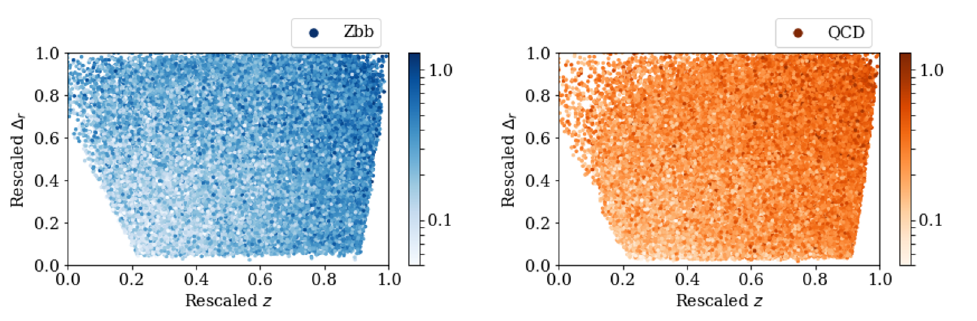
Figure 20. Averaged relevance score of 5 models for the particle list CNN for ∆ R subjets vs z for the Zbb and QCD samples. Analogous to the gradient plots of θ vs z in figure 13 for the Toy